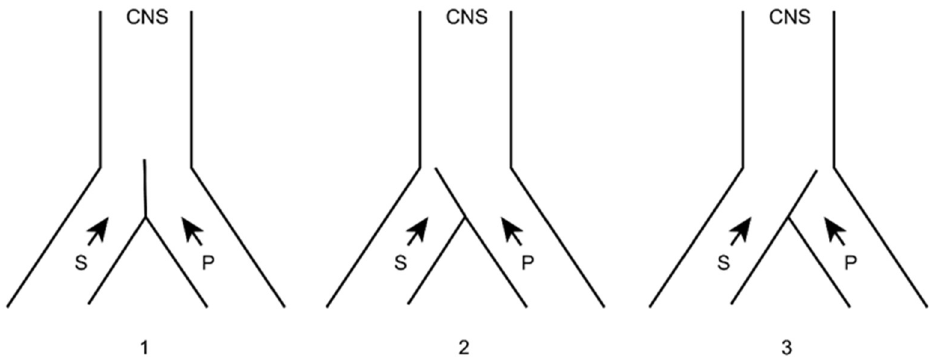
Figure 5. Melzack and Wall gate control theory. 1: Normal. 2: Increased pain afferents. 3: Increased sensory afferents. (see text). CNS: Central Nervous System. S: Sensory afferents. P: Pain afferents.